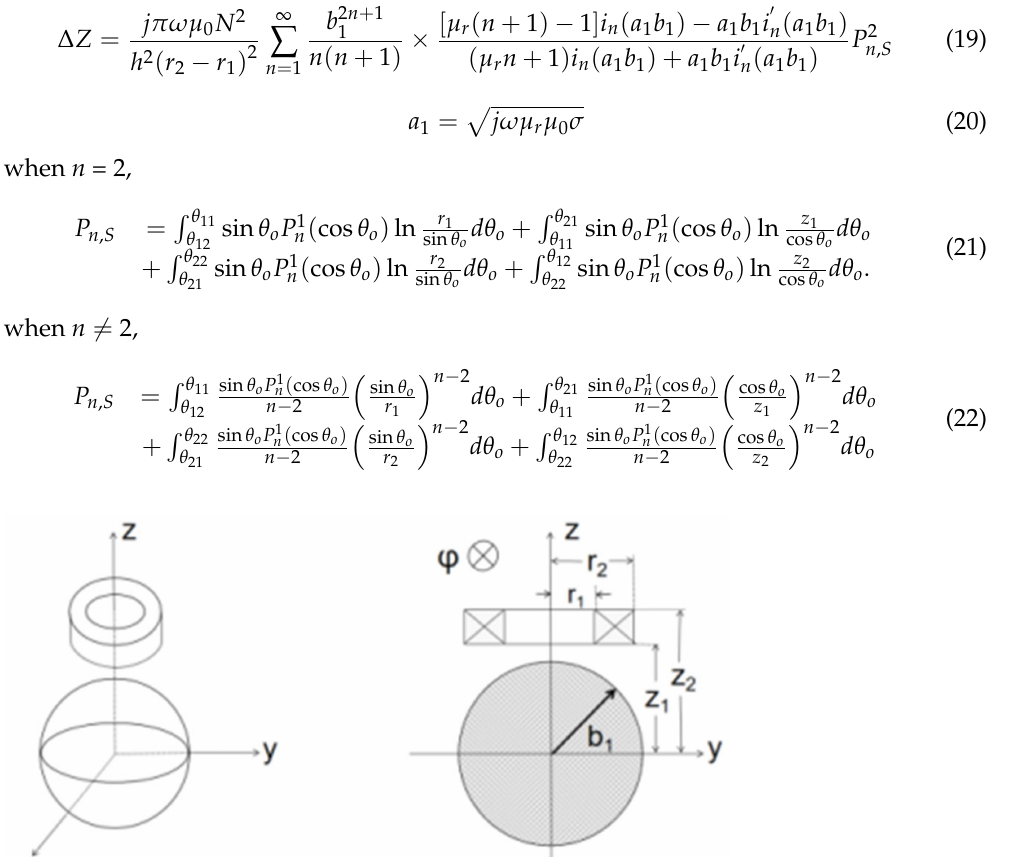
(cid:0) (cid:1) r i / z j ; i , j = 1, 2. i n denote the is the n